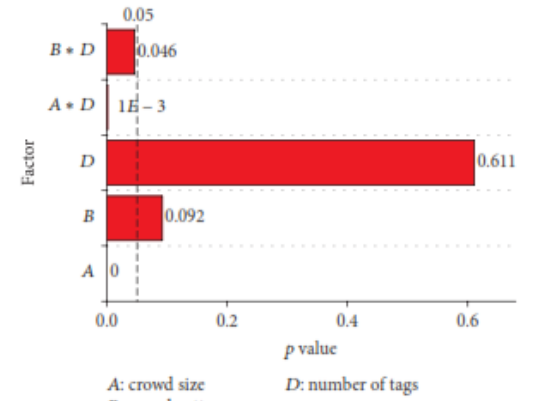
Figure 12: Plotting of factors and values